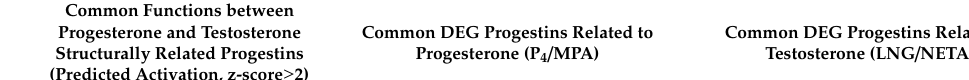
Table 5. Common biofunctions and associated di ff erentially expressed genes between progestins without and with addition of E 2 . E 2 : estradiol; P 4 : progesterone; MPA: medroxyprogesterone acetate; LNG: levonorgestrel; NETA: norethindrone acetate; Vh: vehicle; DEG: di ff erentially expressed